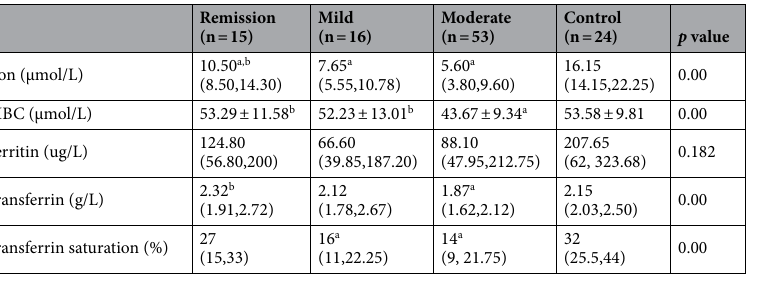
Table 2. Comparison of the serum indicators among patients classified by CDAI scores and controls. TIBC: total iron binding capacity. For TIBC: One-way ANOVA. For the other parameters: Kruskal–wallis H test. p < 0.05 means that the distribution of values in each group is not equal. The letter a means that the difference is significant when compared to the controls separately. The letter b means that the difference is significant when compared to the moderate group